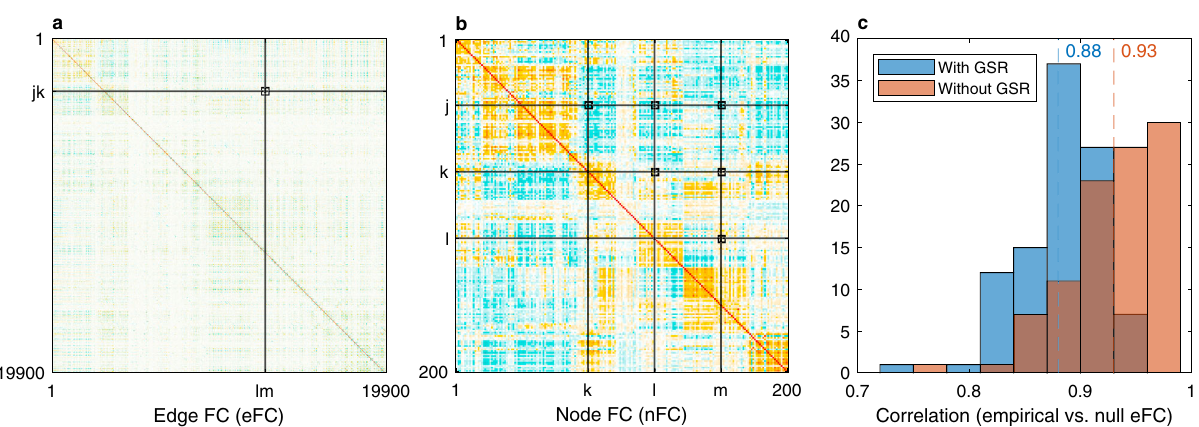
Fig. 1 The edge functional connectivity (eFC) can be derived analytically from the node functional connectivity (nFC) under the static Gaussian null model. a The eFC of the fi rst subject from the Human Connectome Project (HCP) fMRI dataset is plotted as an example. This matrix scales with the fourth power of the parcellation size: in the current case of 200 parcels, it has ~400 million elements. The ( jk , lm ) entry of the eFC matrix (black square at the intersection of the black lines) is computed as the inner product of two edge time series jk and lm , normalised to the [ − 1, 1] interval. b Under the static null model, the eFC of each subject can be derived analytically as a sum of pairwise products between the ( j , k , l , m ) entries of the corresponding nFC matrix as per Eq. (1). Since the nFC is symmetric, only six entries are necessary to represent all pairwise combinations (marked by each of the black squares at the intersections of the black lines). c Distribution of Pearson correlation coef fi cients between the empirical and null eFC computed over 100 HCP subjects. Results are reported with and without global signal regression (GSR) and the mean correlation values are indicated by the dashed